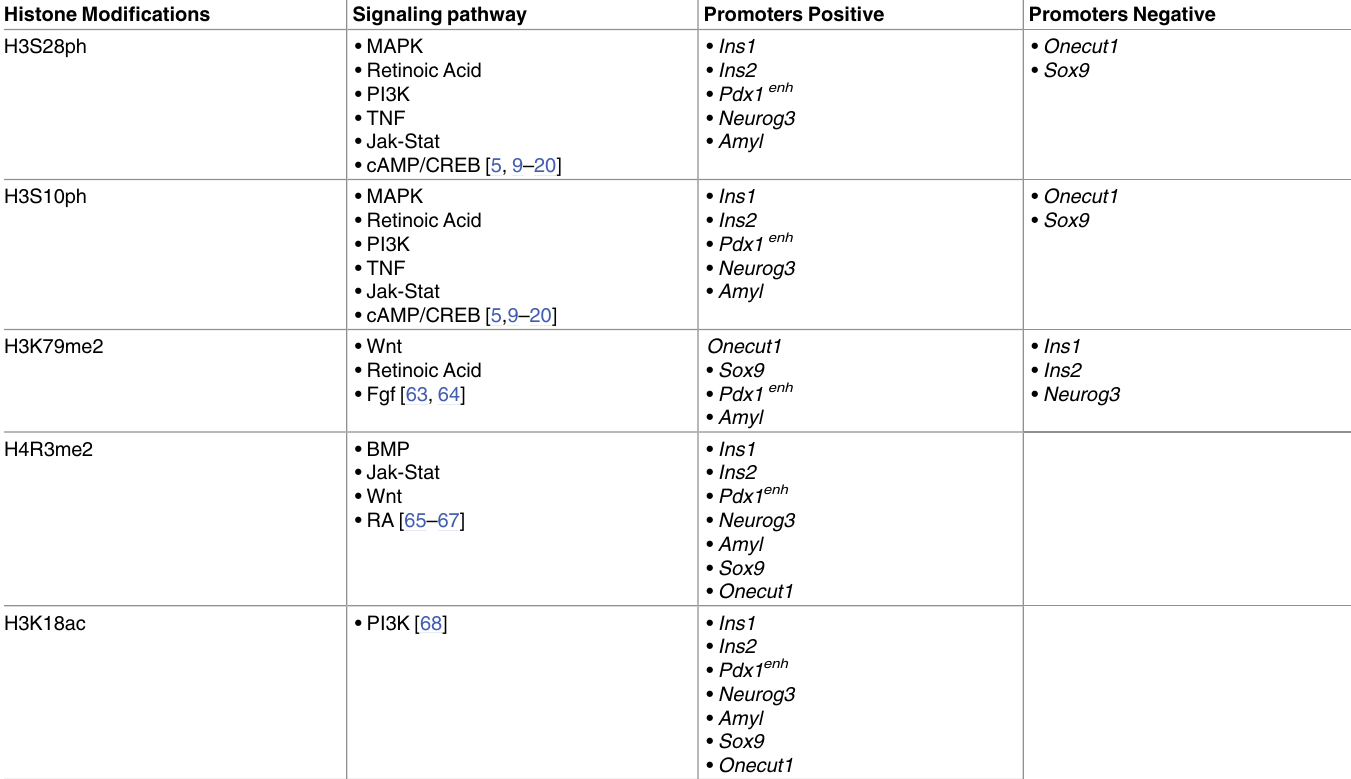
Table 1. Summaryof histone modifications, corresponding signaling pathways, and enrichment found in this study at gene promoters. Histone